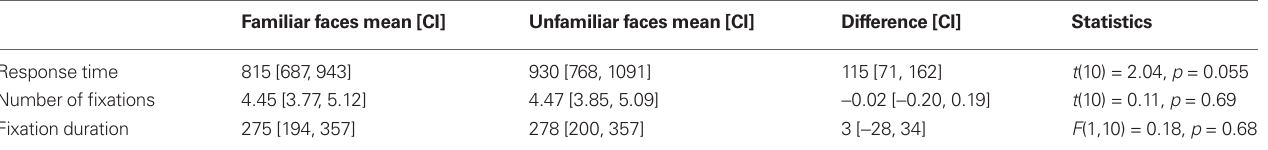
Table 2 | Mean response time, number of fixations, fixation duration and respective confidence intervals (Ci) for familiar and unfamiliar face stimuli, as well as statistics for comparisons of conditions for each